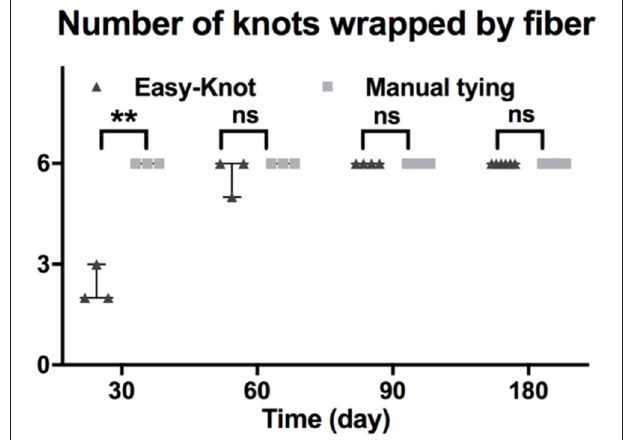
Frontiers in Cardiovascular Medicine |